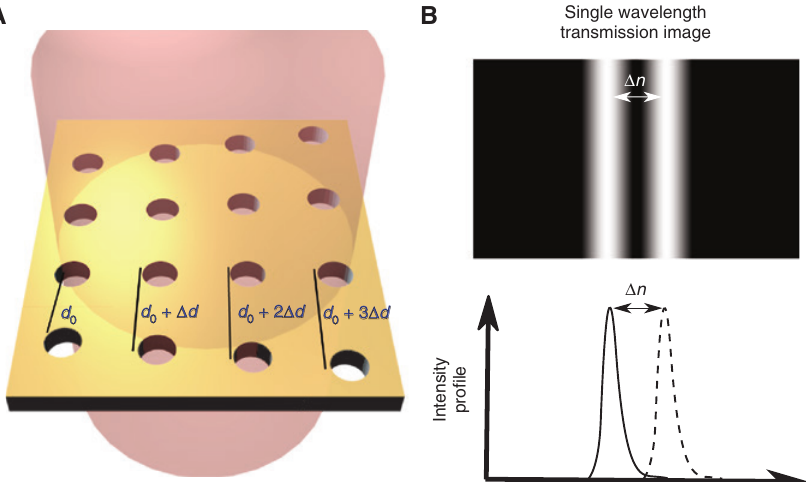
Figure 1: Schematic of the nanohole array structure and working principle. (A) Multiperiodic nanohole array. Each column has a periodicity equal to d column, and Δ d is the increment. (B) The transmission image of the structure at a single wavelength will exhibit a bright fringe for a column with periods that match the resonant condition of the array. Changing the refractive index will move the fringe, and the position of the maxima gives the sensing